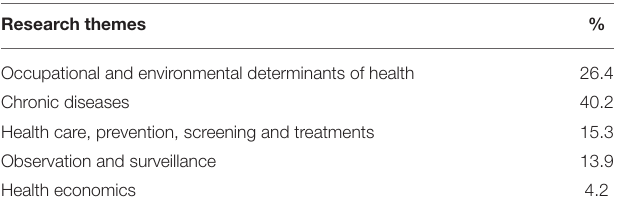
TABLE 6 | Distribution of the current research projects of the CONSTANCES Cohort (March